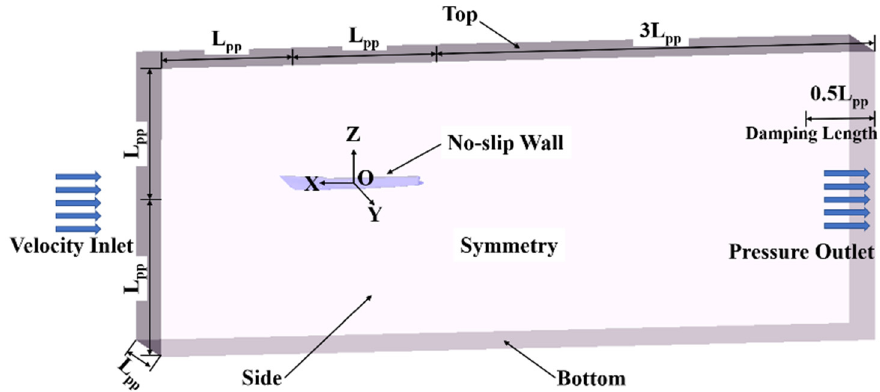
Figure 3. Computational domain and boundary conditions.